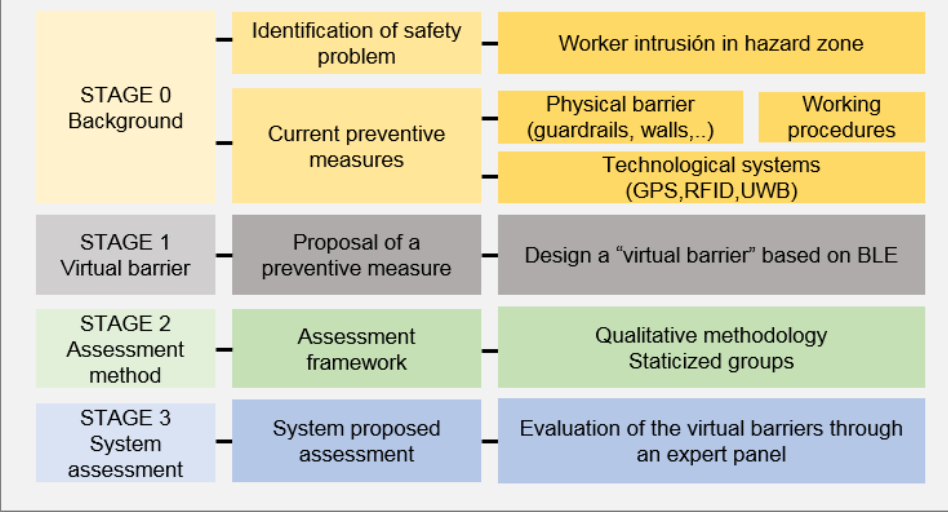
Figure 1. Methodological